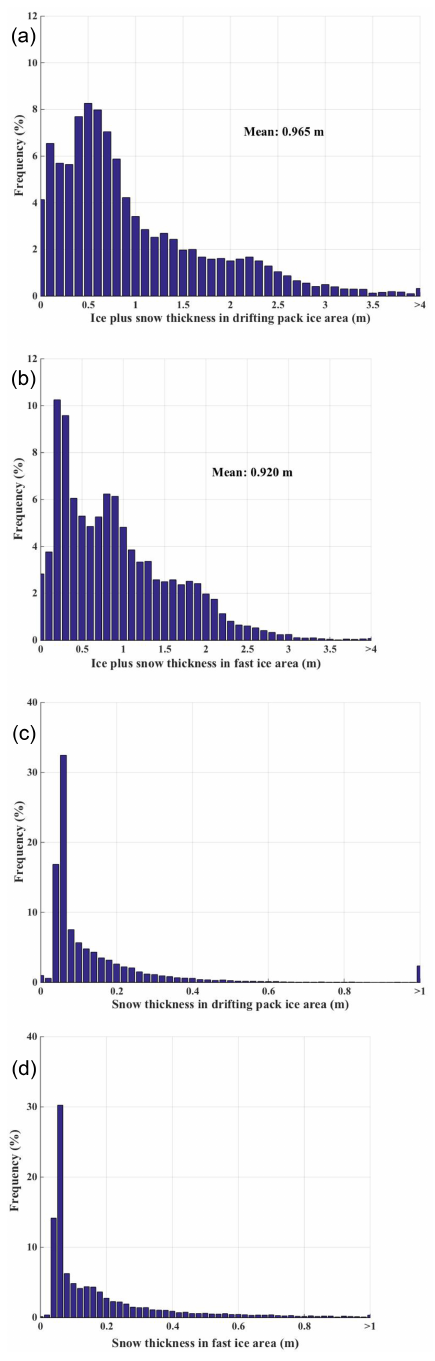
Figure 9. Histogram of ice and snow thickness in the Labrador Sea. (a, b) Ice plus snow thickness collected with EMSs in the pack ice (a) and in the fast ice area (b) . (c, d) Snow thickness collected with GPR in the pack ice (c) and in the fast ice area (d) . The bin widths of ice and snow thickness and snow thickness are 0.1 and 0.02m respectively. The histograms of the fast ice area are gener- ated from flight tracks of P1, P2, P5, and P7. The histograms of the pack ice area are generated from flight tracks of P3, P4, P6, and P8. These histograms include both level and deformed